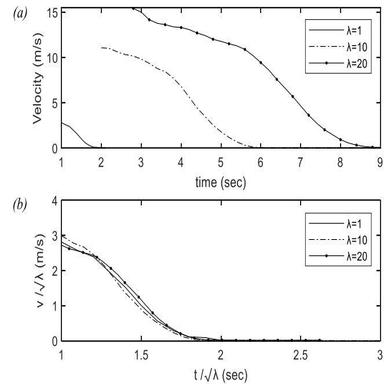
(a) Average flow velocity upstream of the obstacle, (b) Normalised velocity by √λ .